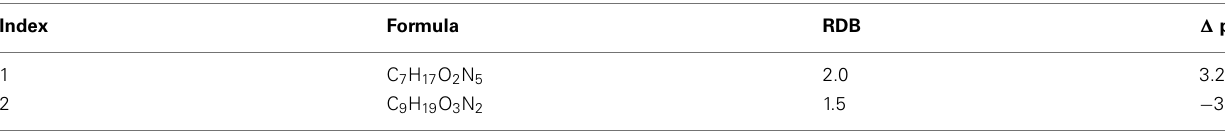
TableA2 | Chemical formulae calculated with m/ z 203.